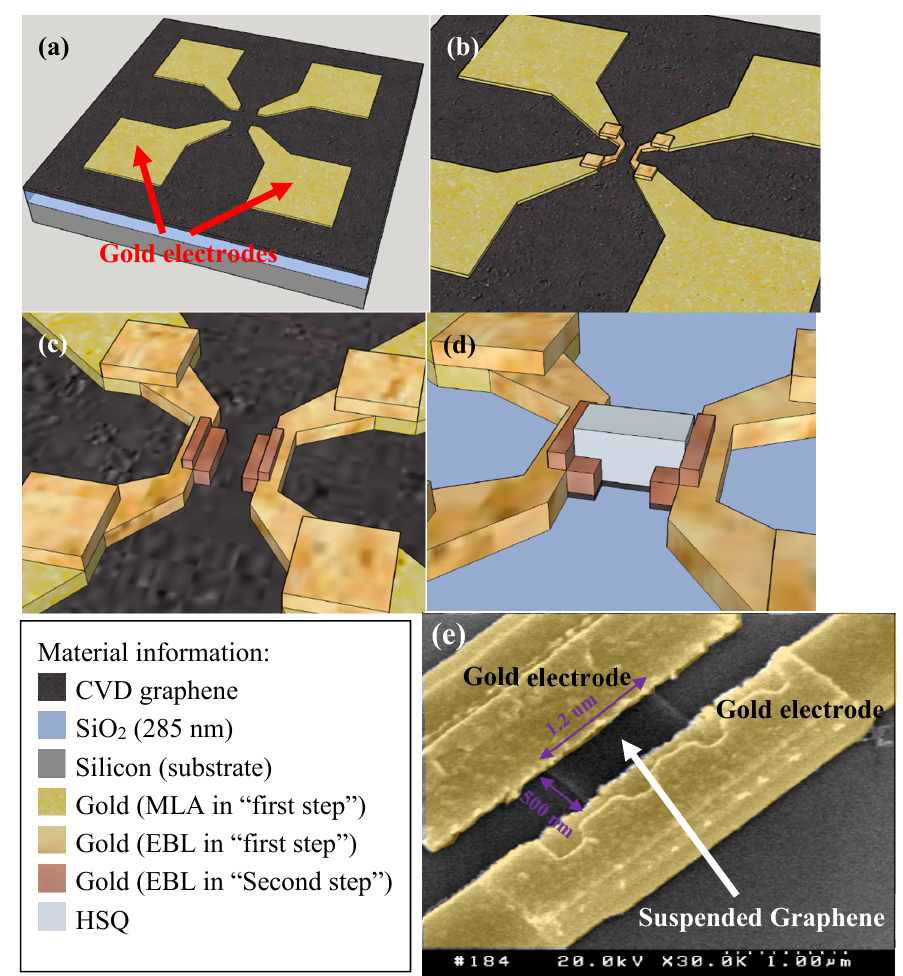
Figure 2. ( a ) Large gold electrodes patterning by MLA in the ‘first step’. ( b ) Small gold electrodes patterning by EBL in the ‘first step’. ( c ) The gold electrodes patterning by EBL in the ‘second step’. ( d ) The HSQ patterning by EBL and redundant graphene etching. ( e ) The SEM image of the suspended GNR device. False colored yellow regions are Au electrodes. In the middle, it remains a 500 nm long and 1.2 um wide suspended graphene.